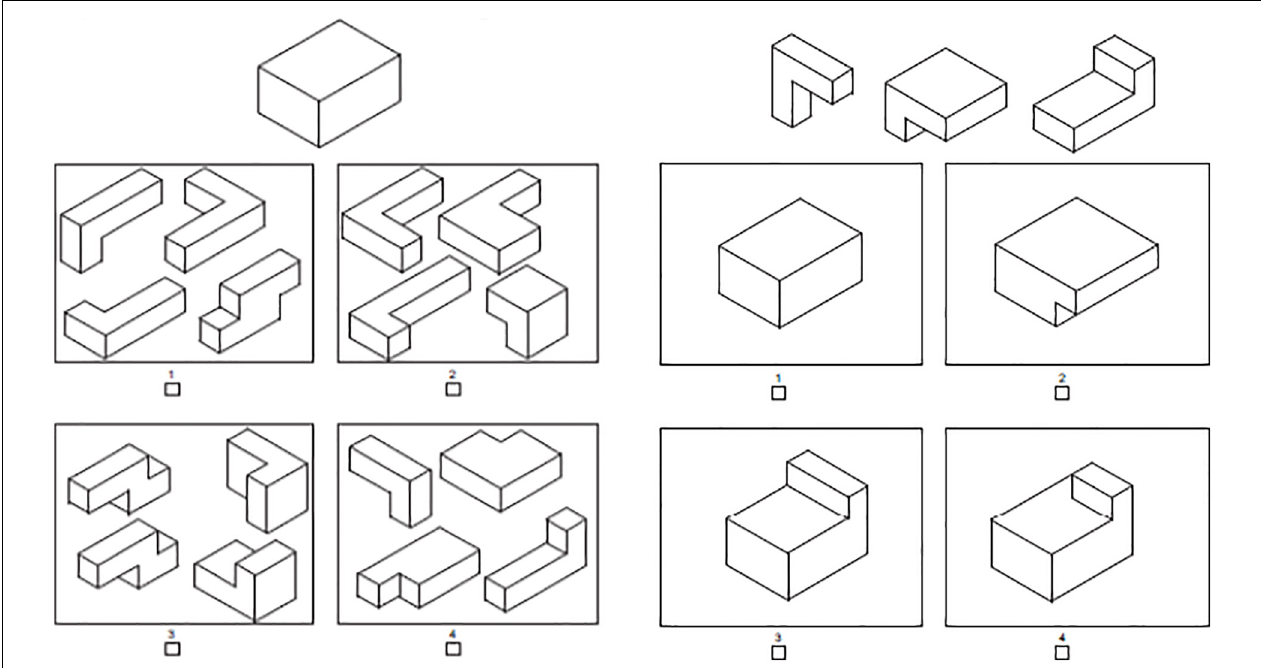
FIGURE 3 | Example items from Packing. Left: whole-to-part item. Right: part-to-whole item.